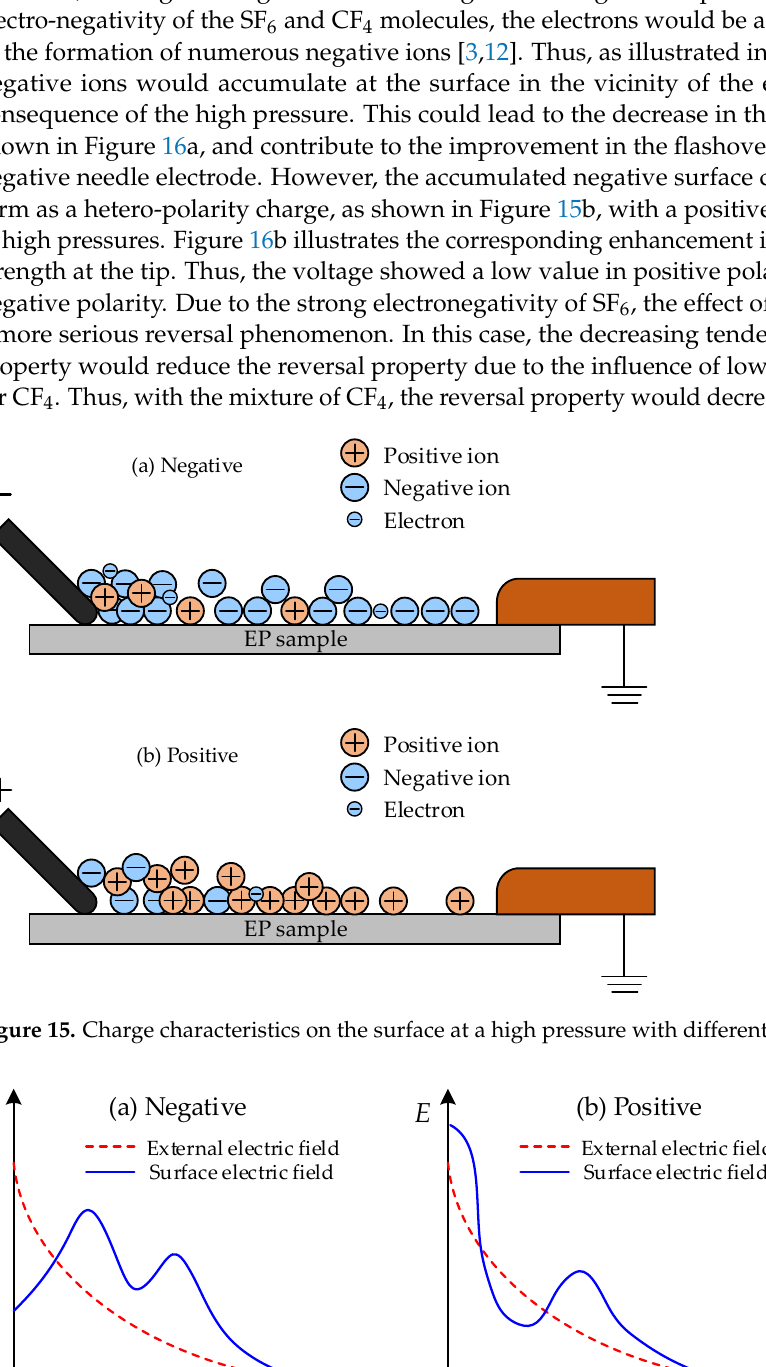
12 of 15 Figure 14. Electric field distribution at a low pressure with different polarities.